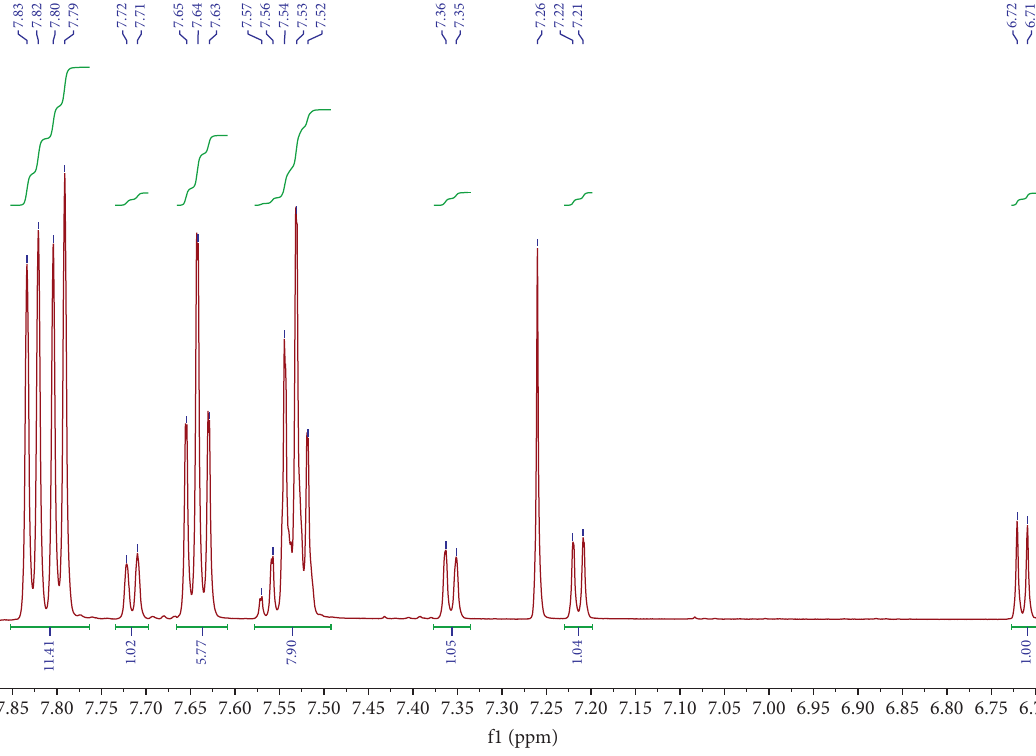
3 containing both